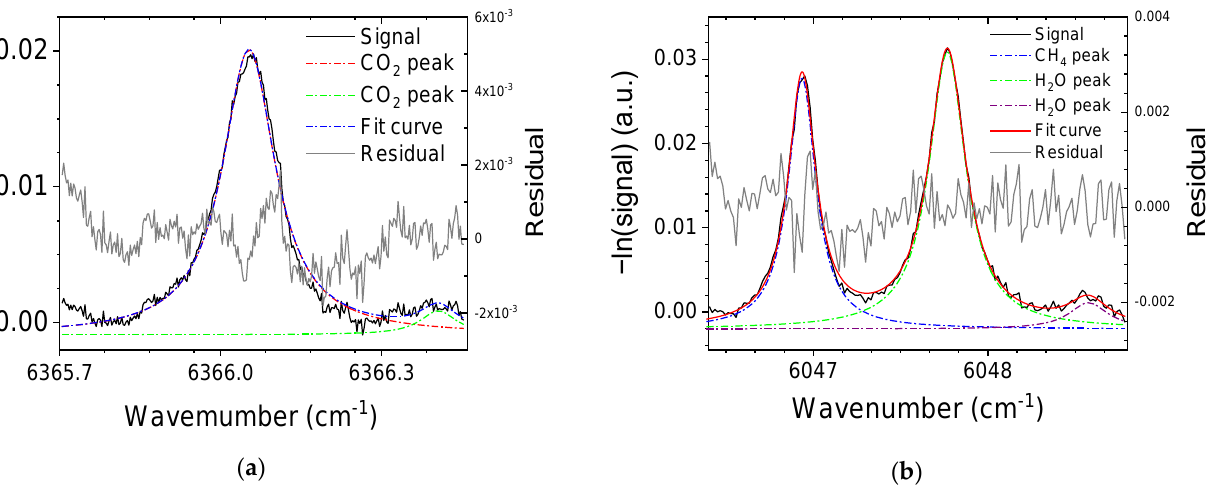
Figure 8. Typical ( a ) CO 2 signal, fitted function, and the residual between the fitted profile and the CO 2 signal; and ( b ) CH 4 and H 2 O signal, fitted functions, and the residual between the fitted profile and the CH 4 signal.